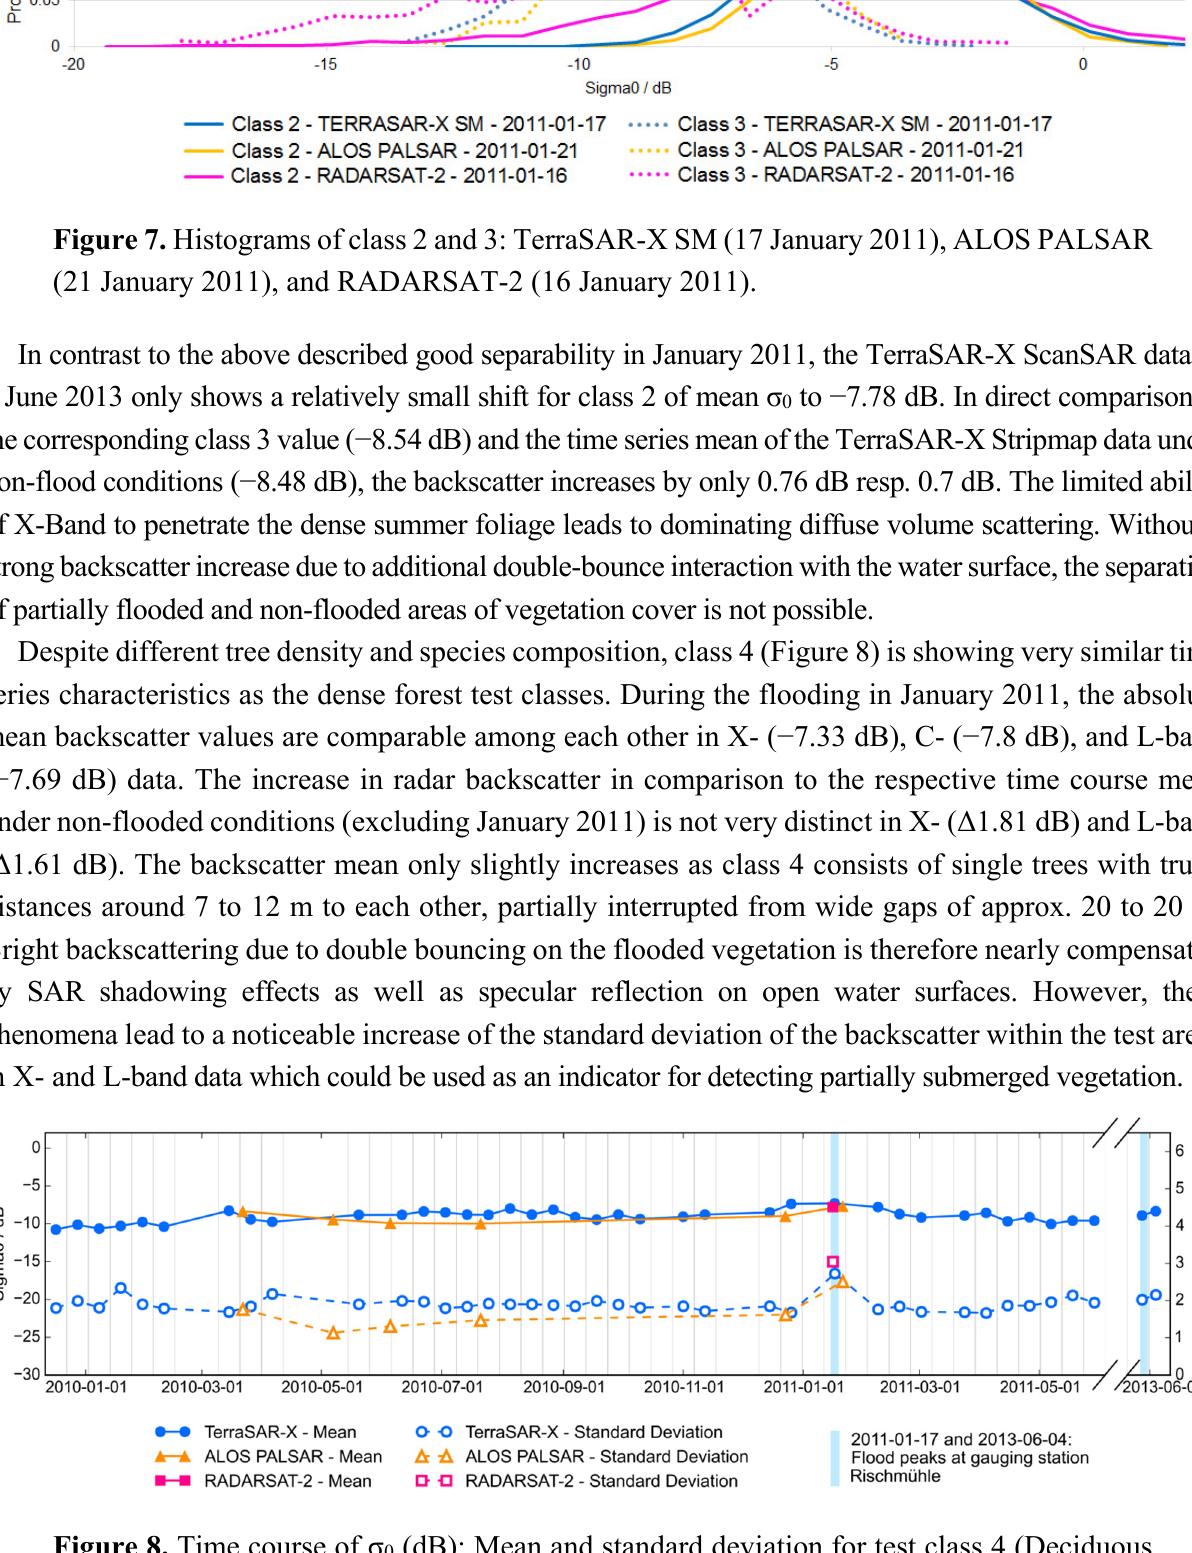
Figure 8. Time course of σ 0 (dB): Mean and standard deviation for test class 4 (Deciduous forest, sparse,